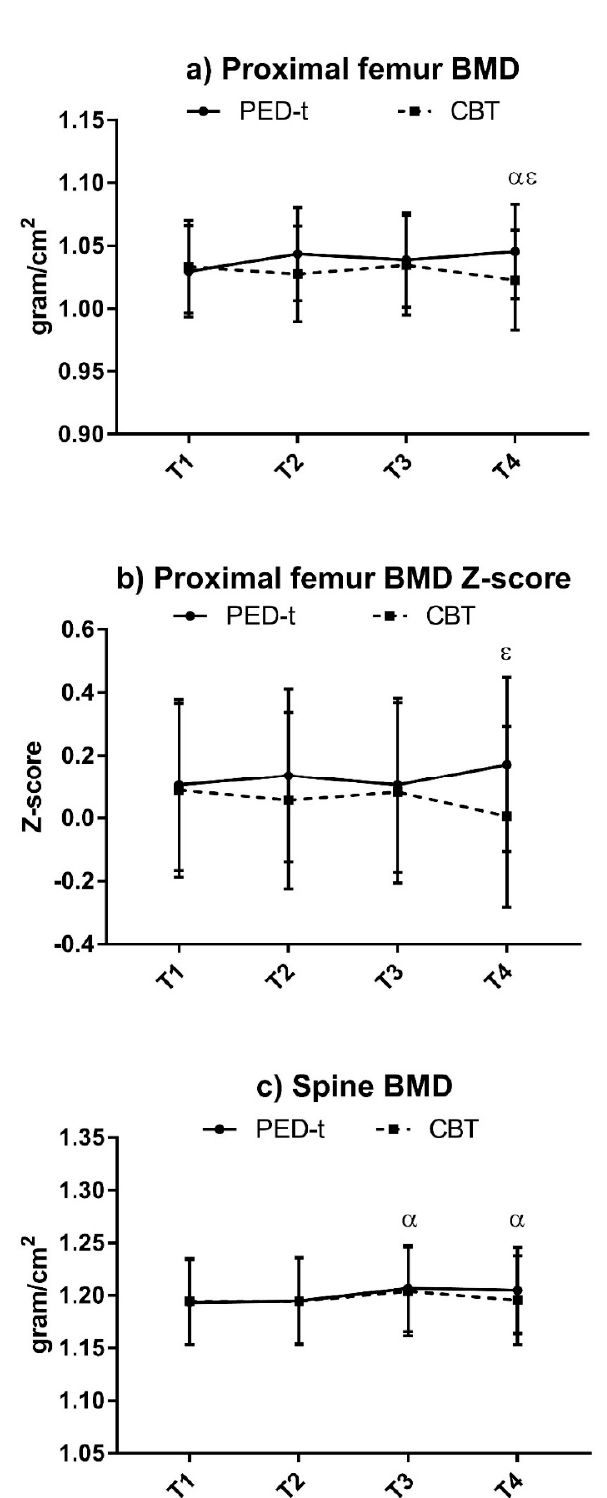
Figure 3. Changes in proximal femur bone mineral density (BMD), proximal femur BMD Z -score, and spine BMD after PED-t or CBT. Results are estimated means (99% CI). ( a ) Changes in proximal femur BMD (gram/cm 2 ); ( b ) changes in proximal femur BMD Z -score; ( c ) changes in spine BMD (gram/cm 2 ). PED-t: Physical Exercise and Dietary therapy; CBT: Cognitive Behavior Therapy; 99% CI: 99% confidence interval; BMD: bone mineral density; T1: baseline; T2: post-treatment; T3: 6 months post-treatment; T4: 12 months post-treatment; α : significant within-group change from T1 in PED-t ( p < 0.01); ε : significant between-group difference ( p < 0.01).